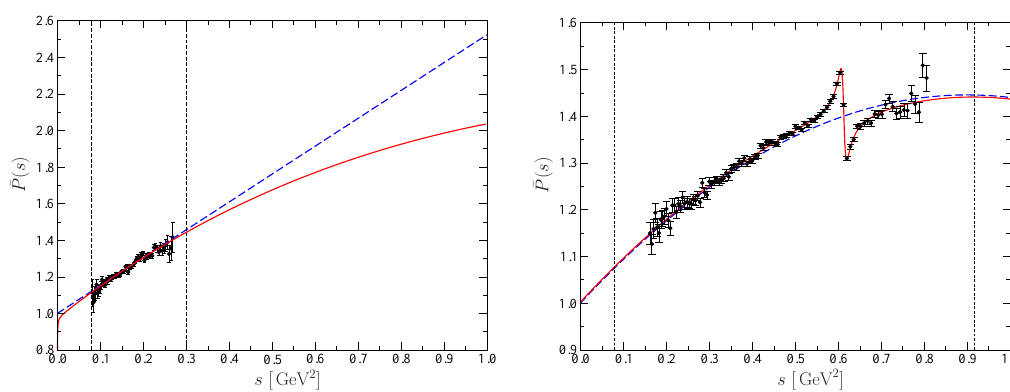
π + π − γ [12] to allow for comparison to the → π + π − γ [14], showing the theoretical fit of → and s = M 2 π η ( ′ )